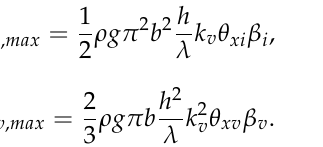
Table 7. The empirical coefficient value 𝑘 𝑣 [15].